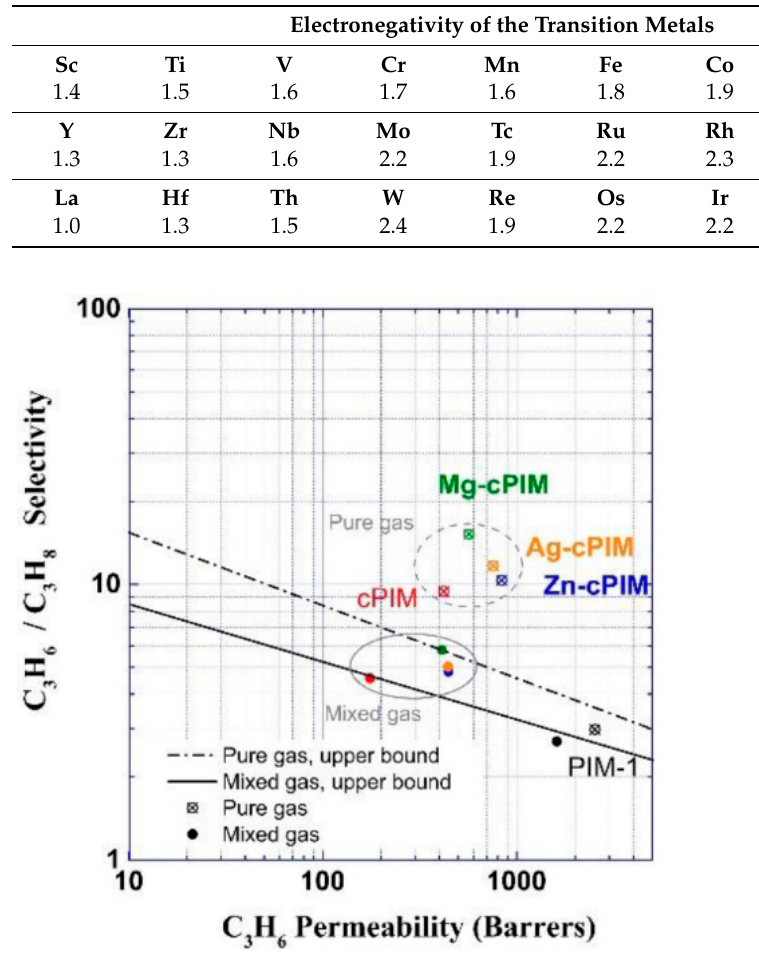
Table 4. Electronegativity of the transition metals [5].